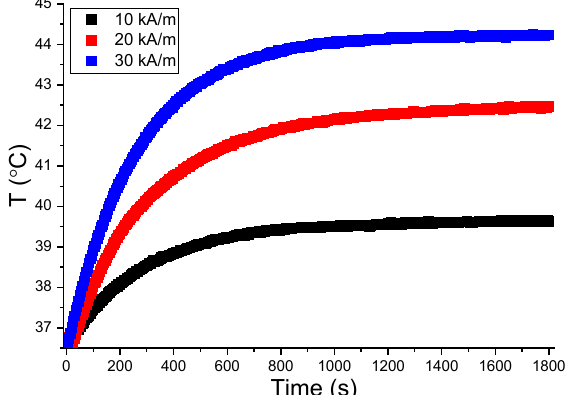
Figure 7. Typical heating curves of TsMLs mixed with A549 cells at a concentration of 0.2 mg Fe /mL in a volume of 500 μ L at different H max values: 10, 20, and 30 kA/m at a constant frequency of 355 kHz.